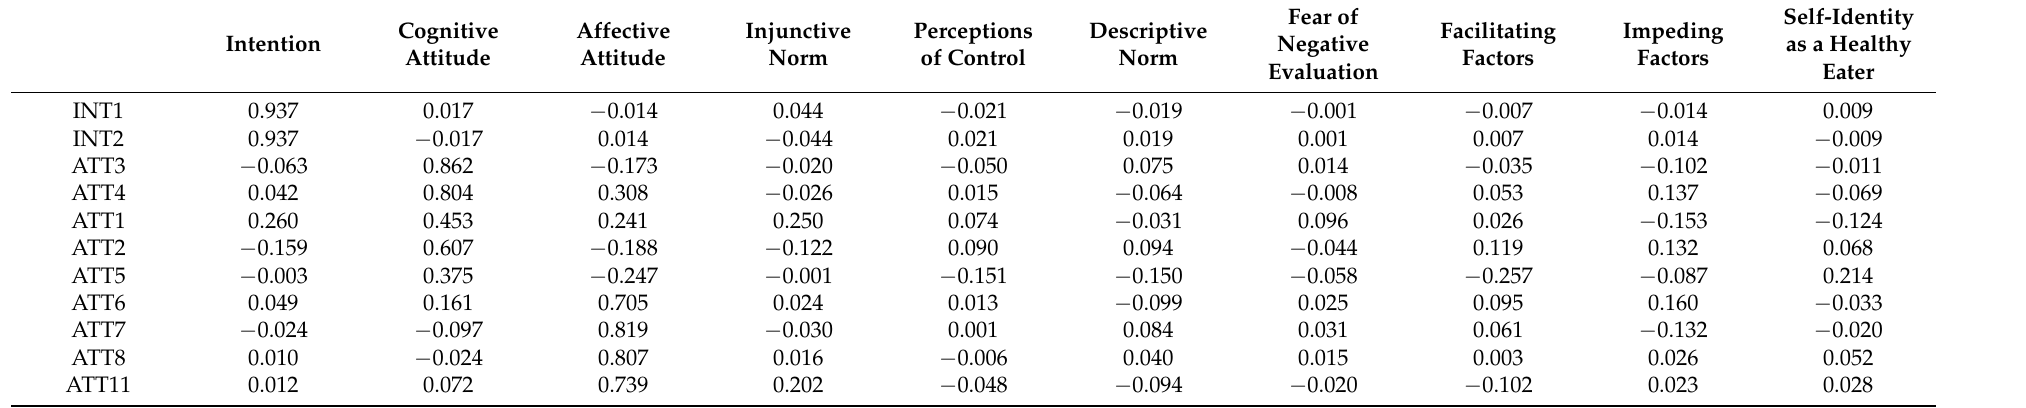
Table A3. Discriminant validity (intercorrelations) of variable